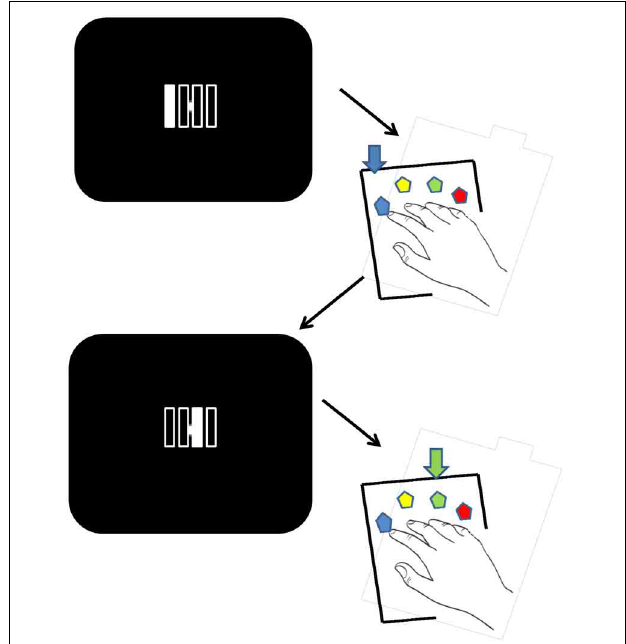
FIGURE 1 | Stimuli and experimental procedure. Visual stimuli indicate the current key in the sequence. Each stimulus is made up of four unfilled vertical bars that are individually illuminated on each trial in the appropriate order. Each of the four bars corresponds to the spatially congruent key on the response pad. After a correct touch the next stimulus in the sequence is displayed. Faulty key presses were immediately followed by an error message (as a change from a white to a colored visual stimulus). The figure illustrates two stimuli and the corresponding